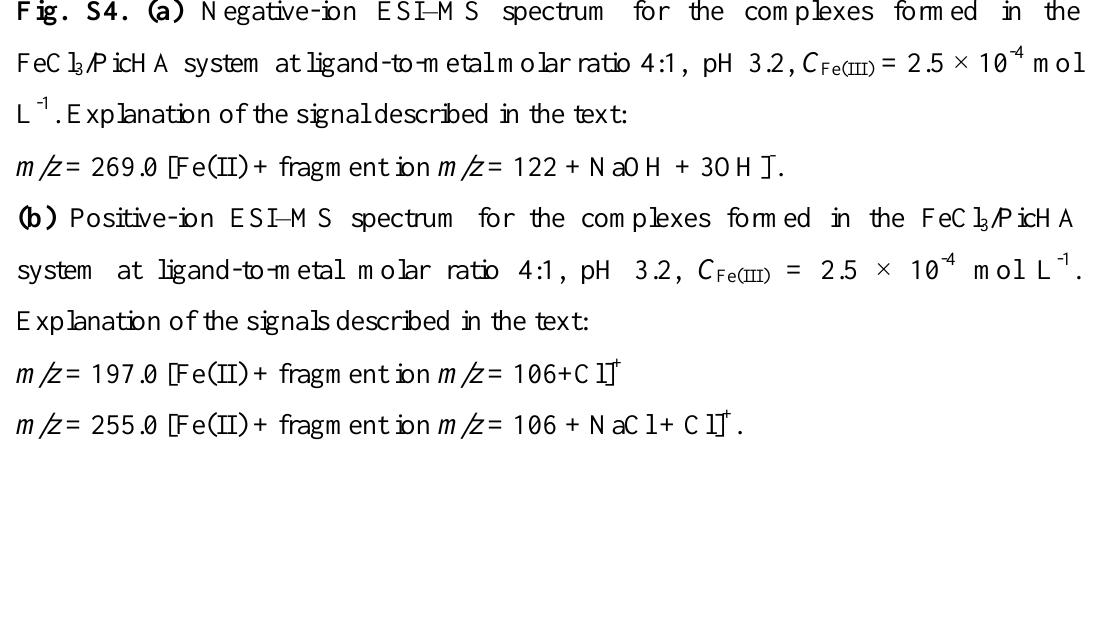
= 2.5 × 10 -4 mol Fe(III) /PicHA 3 = 2.5 × 10 -4 mol L -1 . Fe(III)